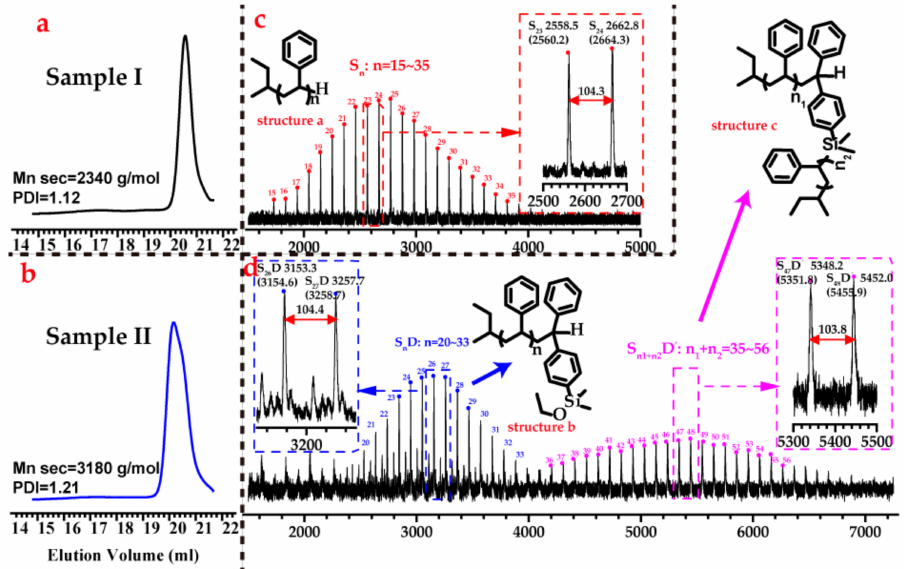
Figure 5. ( a , b ) Size exclusion chromatography (SEC) chromatograms of samples I and II. ( c , d ) MALDI-TOF spectra of samples I and II. The scheme of red peaks shows structure ( a ) homopolystyrene; the scheme of blue peaks shows structure ( b ) end-capped polystyrene; and the scheme of the pink peaks shows structure ( c ) the dimer